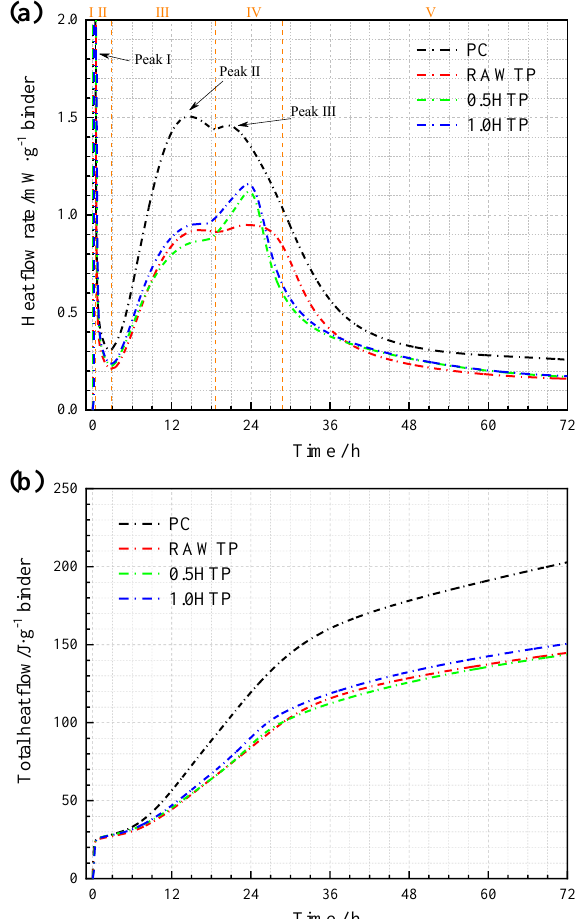
Figure 11. Calorimetry testing result of cementitious binder with and without TPs: ( a ) hydration heat rate; ( b ) cumulative hydration heat